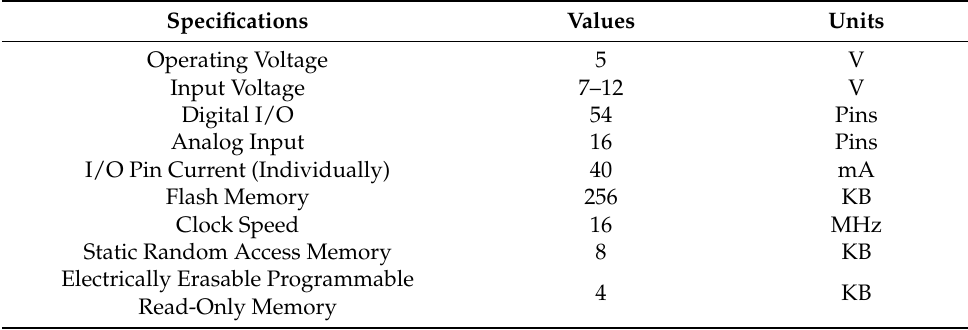
Figure 4. Arduino Mega 2560. Table 3. Technical specifications of Arduino Mega 2560 [28]. Table 3. Technical specifications of Arduino Mega 2560